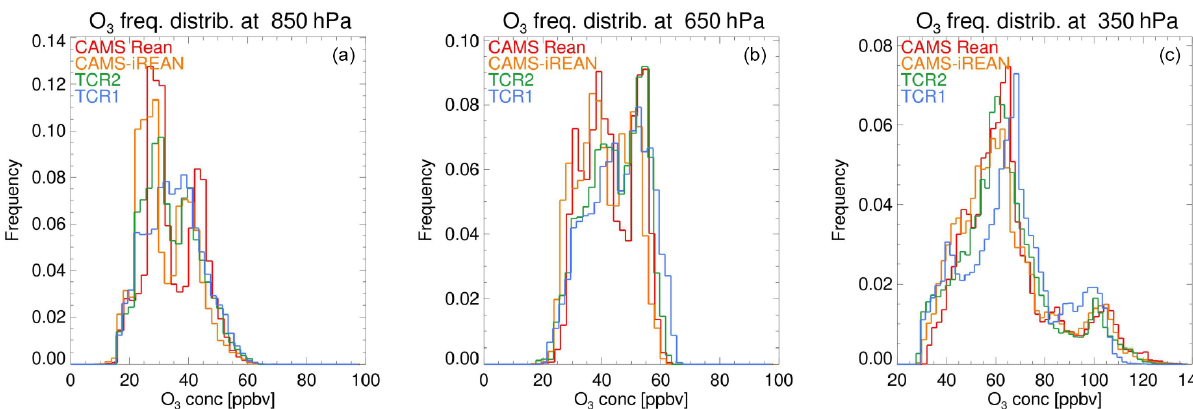
Figure 15. Area-normalized frequency distributions of multiannual (2005–2016) mean O 3 mixing ratios at 850 (a) , 650 (b) , and 350hPa (c) for the four